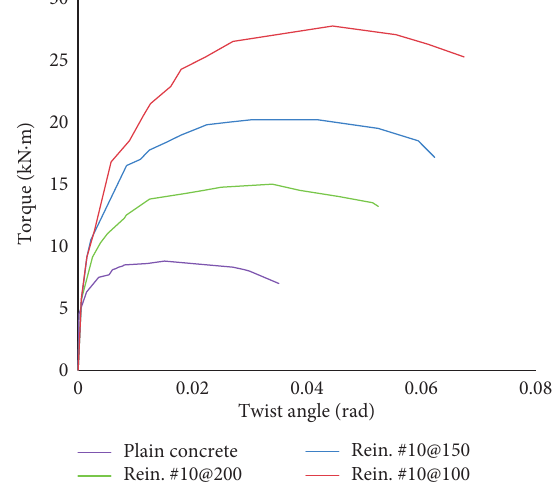
Figure 9: Torque-twist angle relationship of stirrup reinforcement.